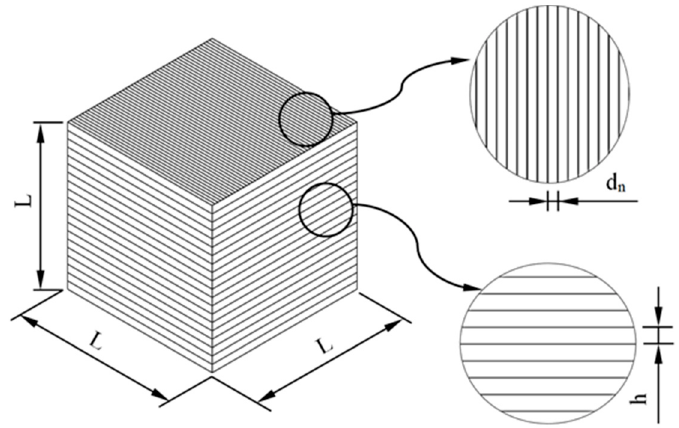
Figure 30. Representation of the cubic element parameterized according to the 3D printing technological parameters layer height h (m) and diameter of the nozzle d n (m).